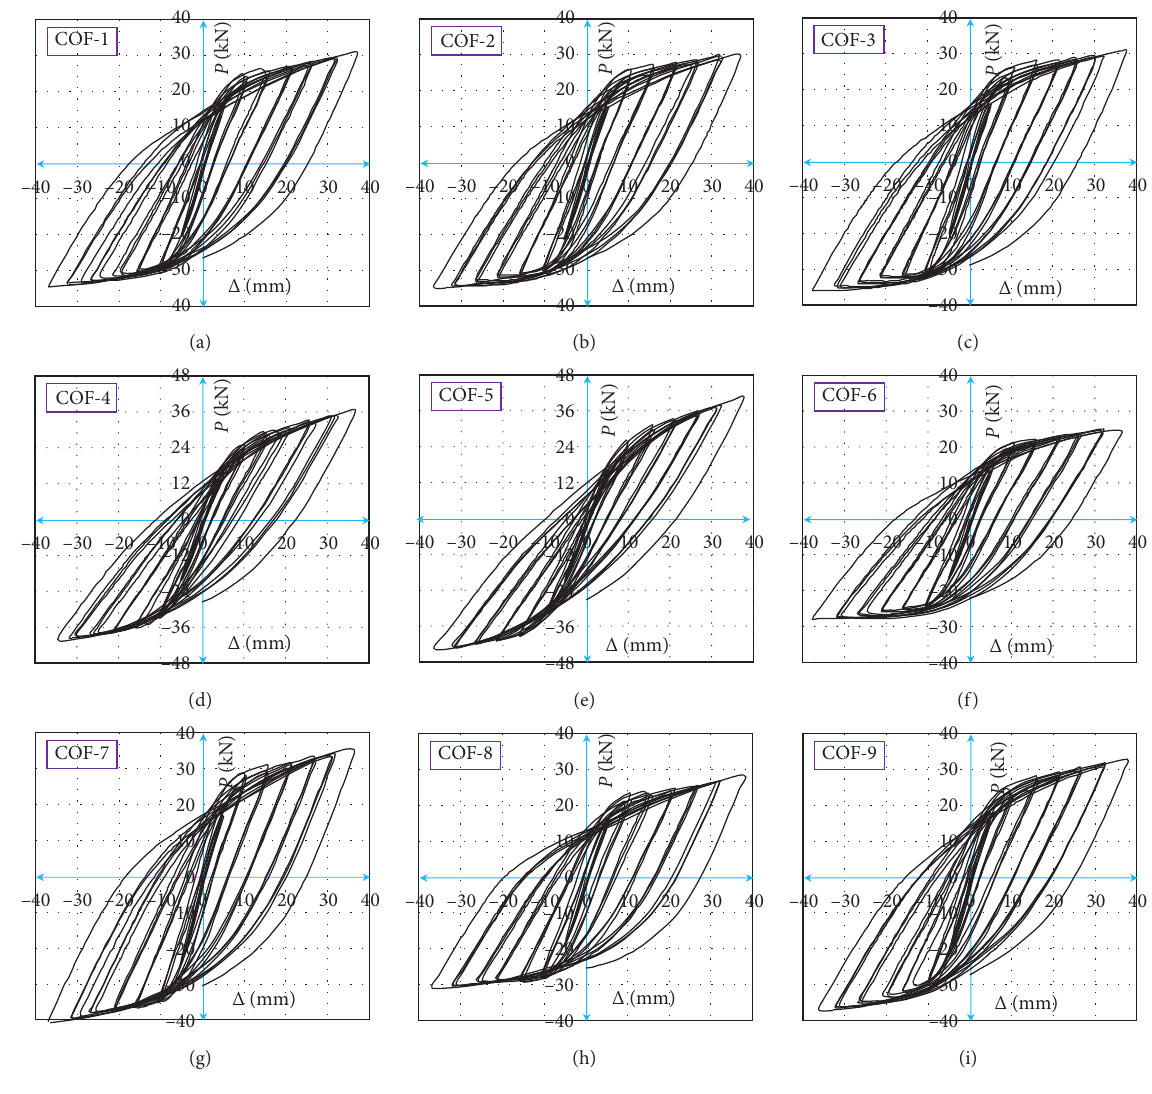
Figure 13: P - Δ hysteretic